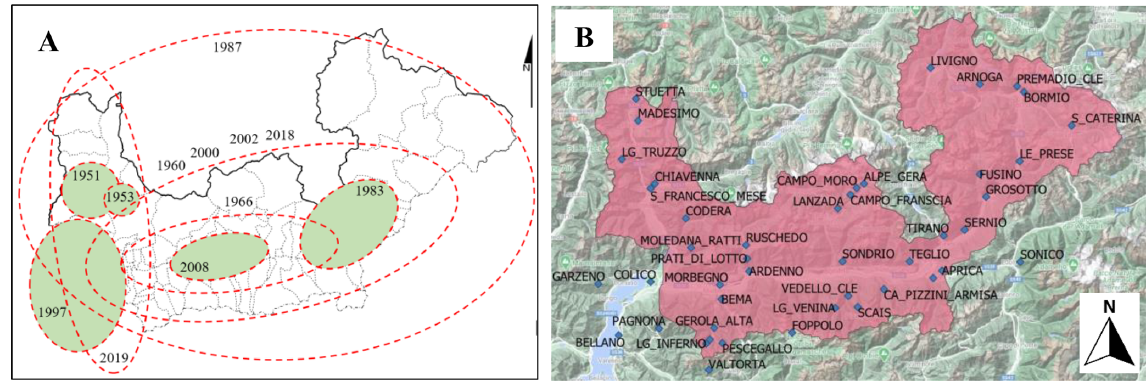
Figure 2. (a) Distribution of critical events across Sondrio Province and (b) the local rain gauge station network considered in the study; base layer from © Google Maps